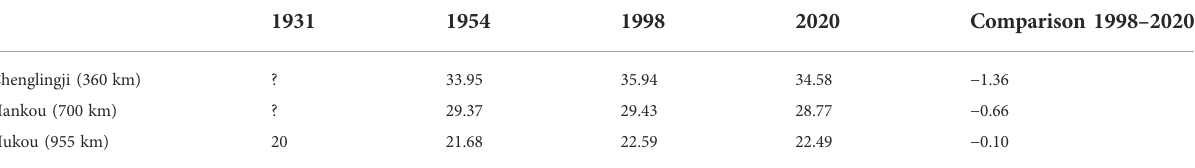
TABLE 1 Maximum river stage (m) during the 1931, 1954, 1998, and 2020 fl oods at three middle Changjiang gaging stations. Downstream distance from the Dam is shown (river